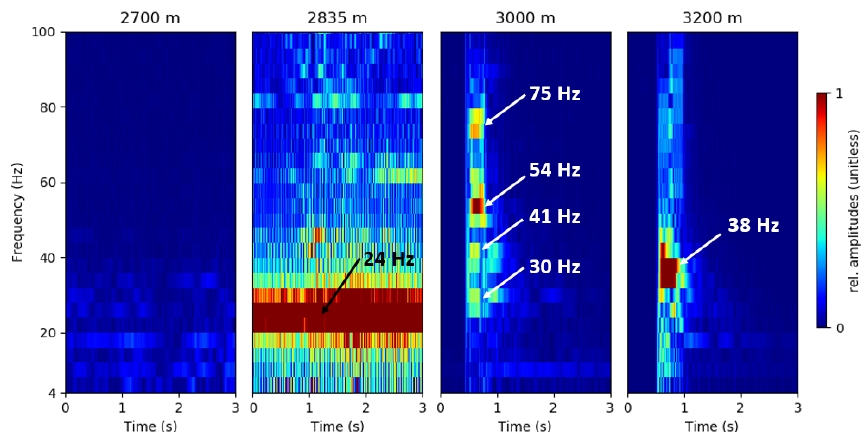
Figure 7. Spectrograms for a 250ms moving window at different depth along the well during the sudden vibrational event depicted in Fig. 5. Red colors indicate high amplitudes, blue colors low amplitudes. The relative amplitudes are displayed by the same color ranges for all subplots.